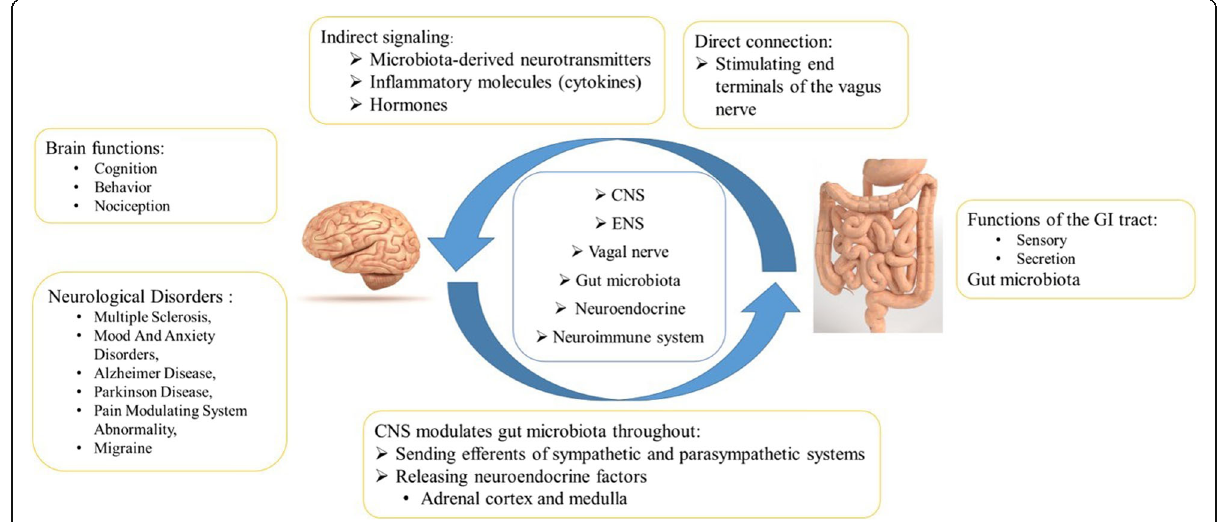
Fig. 1 Gut -Brain Axis. CNS, Central nervous system; ENS, Enteric nervous system; GI,